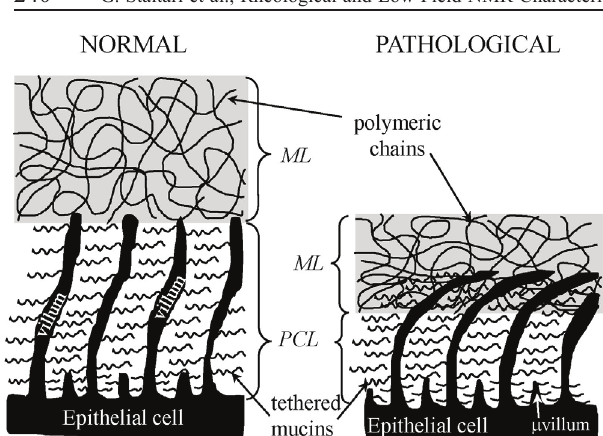
Fig. 1 – Airway surface layer (ASL) is composed of the mu- cus layer (ML) and the periciliary layer (PCL). Both ML and PCL contain polymeric substances so that they show a visco- elastic behaviour. In pathological conditions, the dehydrated ML penetrates the PCL so that cilia beating is hindered and ML removal becomes very slow if not impossible. Adapted from ref.